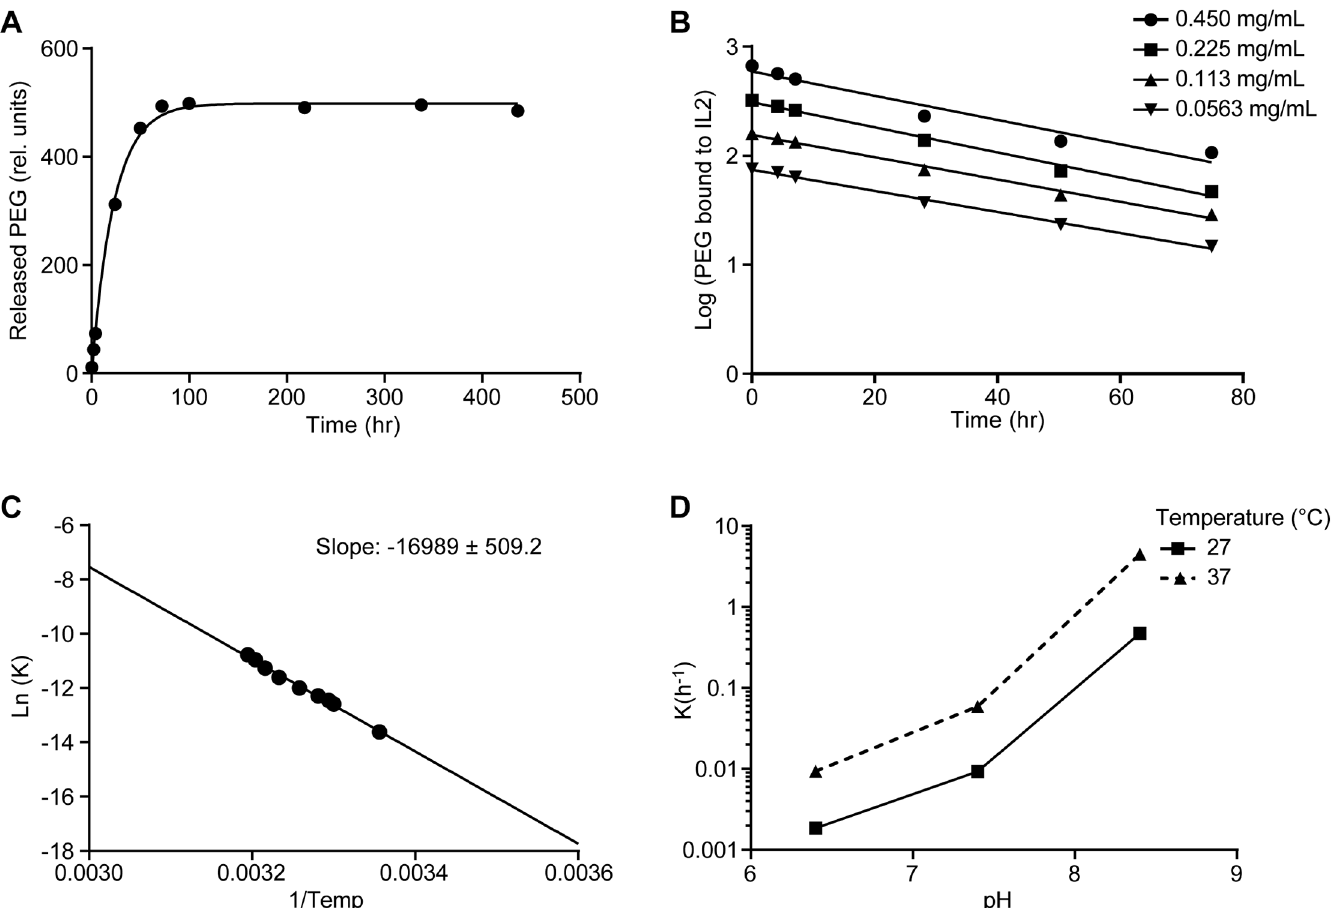
Fig 3. Releaseof PEG chains follows first-order kinetics. A. Free PEG detected at varioustime points duringincubationin 0.5 M sodium phosphate buffer at pH 7.4 and 37˚C (circles) fit to first-order kinetic profile (solid line), B. Semi-logplot of non-released PEG in phosphate buffer at pH 7.4 starting from indicatedconcentrations of NKTR-214 at pH 7.4 and 37˚C. C. Arrheniusplot of Ln(K) versus 1/Temp is linear. CalculatedE a = 130 kJ/mole for PEG release, D. Effect of pH and temperature on PEG release rate–an equalvolume of 0.5 M sodium phosphate buffer at predetermined pH was addedto conjugateto producethe final pH of 6.4 or